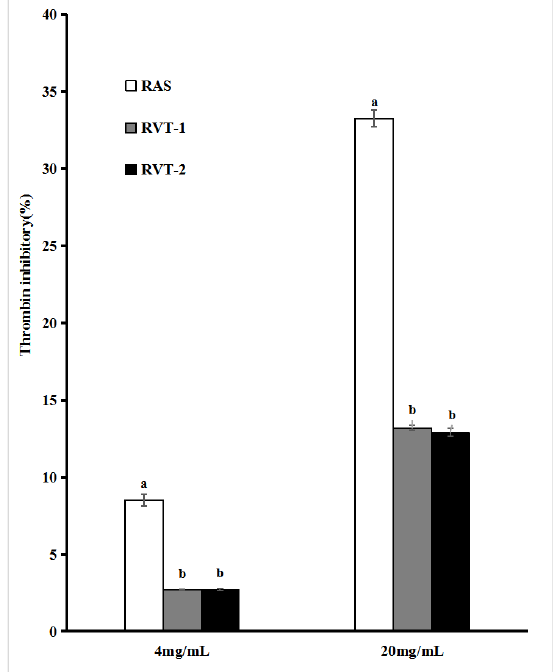
Figure 4. Thrombin inhibitory ability assays for RVT and RAS. Values with different letters within the same substance are significantly different ( p < 0.05). All data were expressed as the means ± SD, n = 3. Molecules 2023 , 28 , x FOR PEER REVIEW